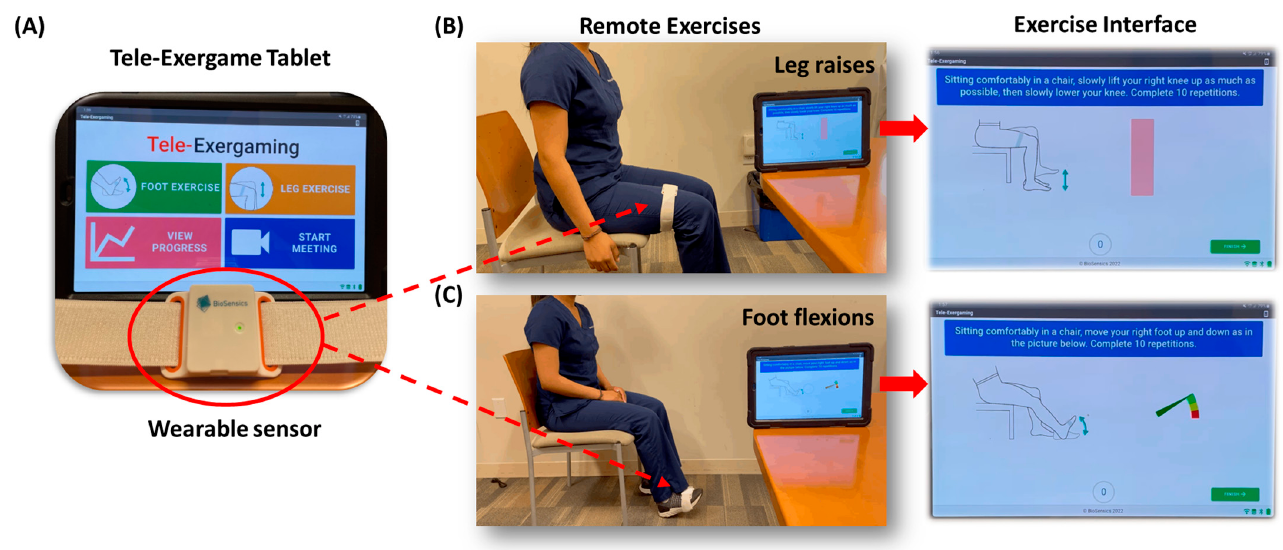
Figure 1. Tele-Exergame system. ( A ) Tablet and wearable sensor. ( B ) Leg raising exercise with the tele-Exergame system. ( C ) Foot flexion exercise with the tele-Exergame system. LEGSys TM includes a triaxial accelerometer ( ± 2 g) and gyroscope ( ± 2000 deg/s), a microprocessor to process sensor data, and a Bluetooth module for wireless data acquisition. LEGSys TM computes 3D rotation using the Kalman filter and quaternion approach, which is described in detail in our previous publications [23–25]. The sampling rate is 100 Hz, and 3D rotation data of LEGSys TM are transmitted to the tablet via Bluetooth with high efficiency and zero package loss.